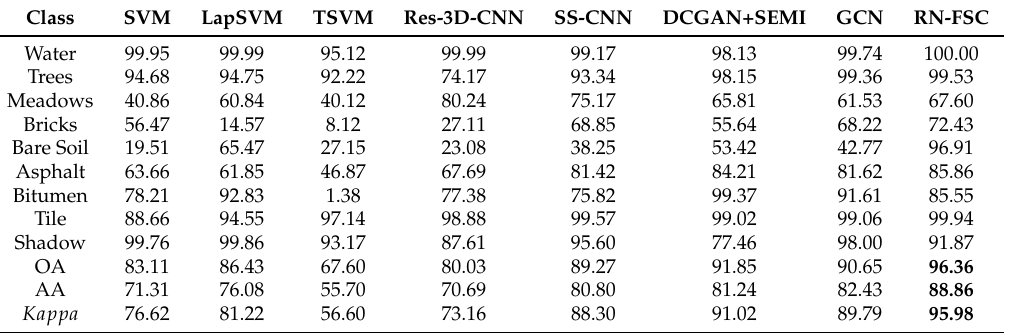
Table 8. Classification results of the different methods on the PC data set (5 samples per class in the fine-tuning data set for RN-FSC; 5 samples per class are used for training for other methods; bold values represent the best results among these